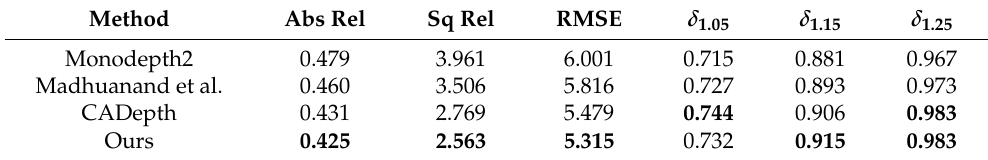
Table 2. Comparison of assessment